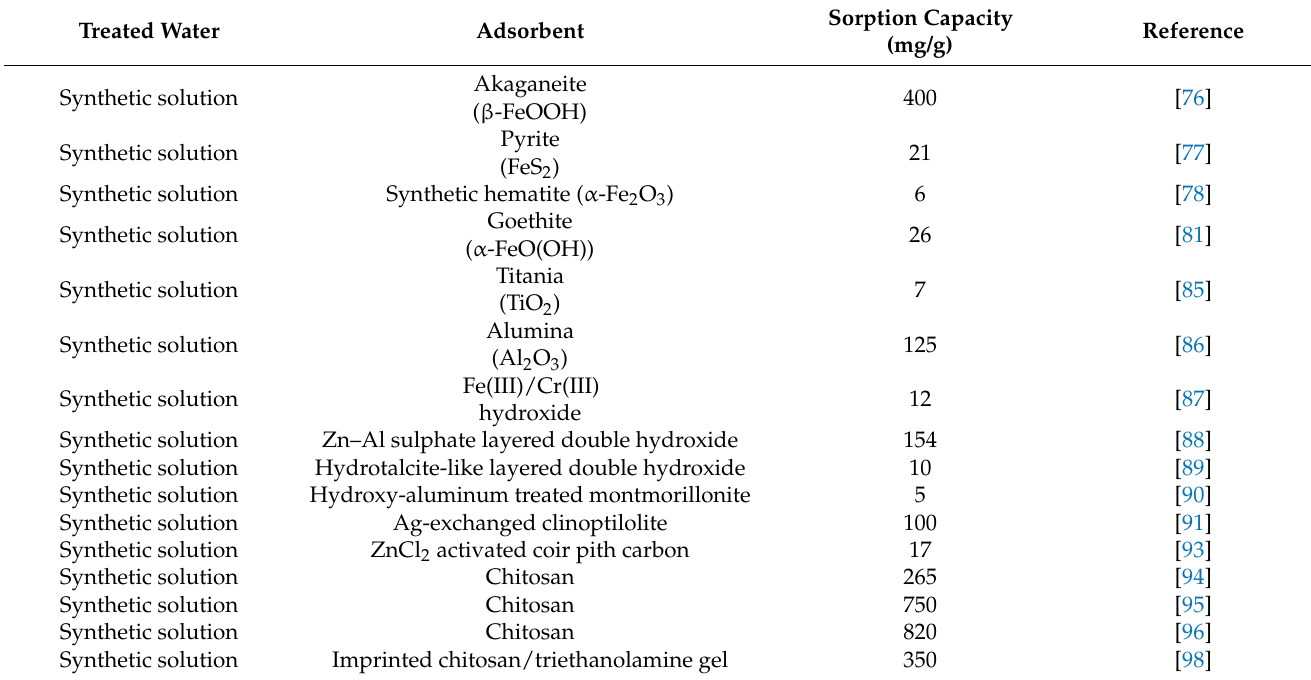
Table 7. Compilation of the sorption capacities of the main adsorbents tested for molybdenum removal from aqueous